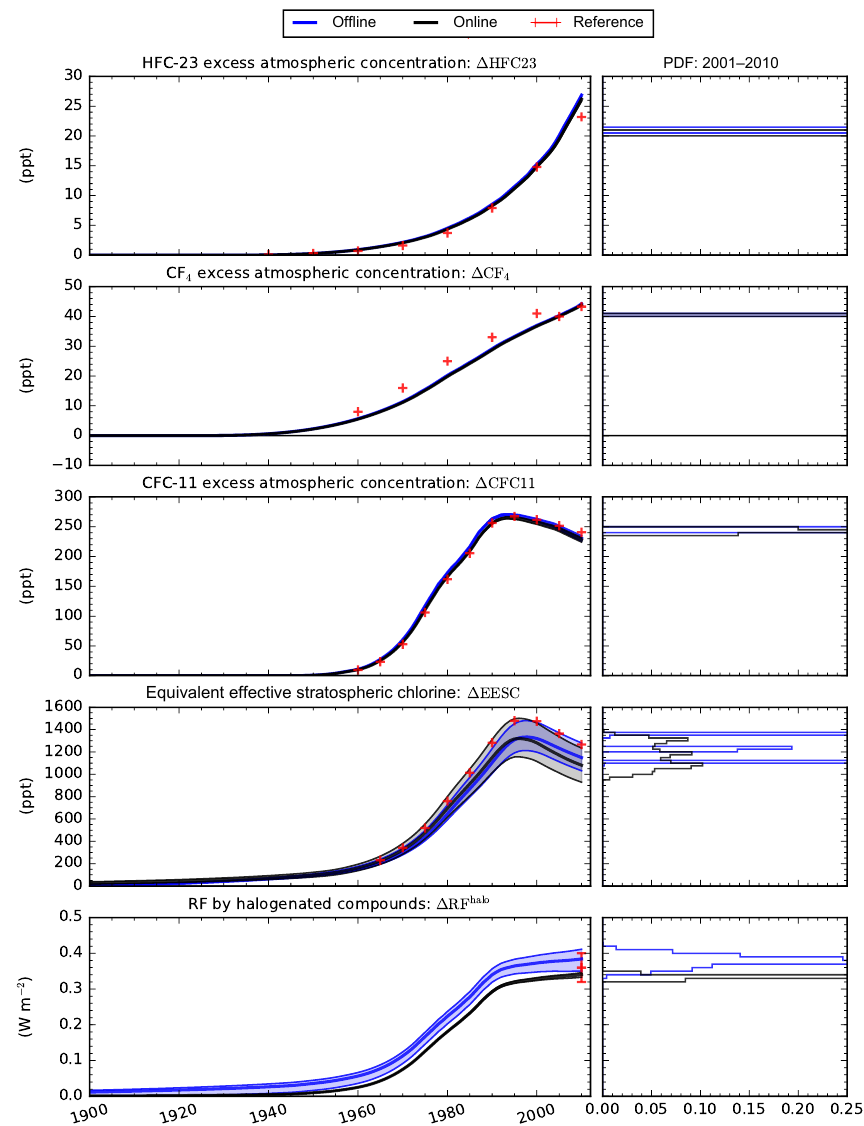
Figure 8. Results of our simulations with OSCAR, for halogenated compounds, with the same format as for carbon dioxide. Reference for the atmospheric concentrations is IPCC (2013); for the EESC it is the same concentrations combined with the fractional release values of Newman et al. (2007), and for the radiative forcing and its 90% uncertainty range it is IPCC (Myhre et al.,